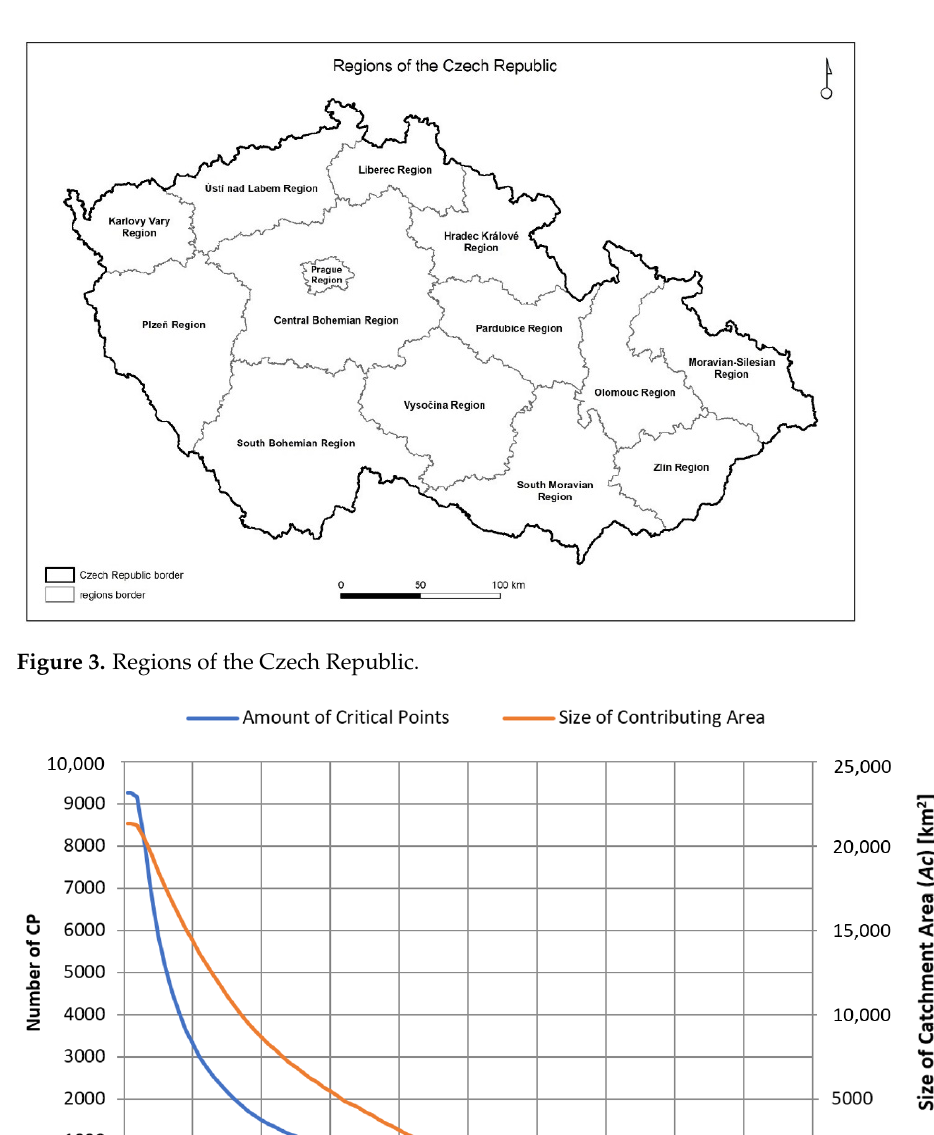
Figure 3. Regions of the Czech Republic.